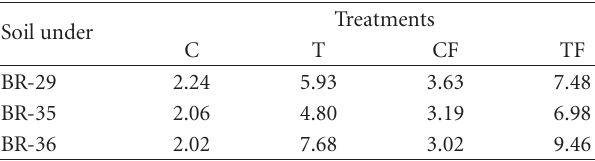
Table 7: Water extractable As (mg kg − 1 ) in the soils after harvest of boro rice. Treatments Soil under C T CF TF BR-29 0.052 0.074 0.06 0.081 BR-35 BDL BDL 0.02 0.067 BR-36 0.001 0.002 0.01